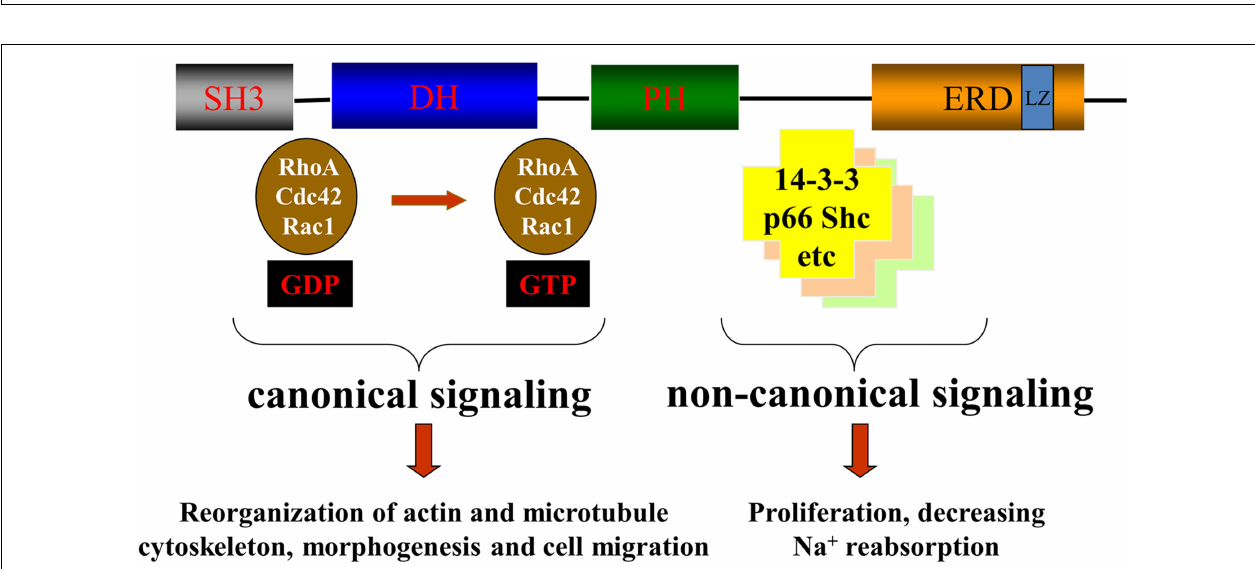
FIGURE 2 | Pix family of proteins. A schematic diagram of Pix family of proteins showing position of protein–protein interaction domains and the similarity between α Pix and β Pix. α Pix (A) and β Pix (B) – two isoforms of Pix family of proteins. β 1 Pix and β 2 Pix are two splice forms of β Pix. Domain structure is depicted. CH, calponin homology/actin binding domain; SH3, SRC Homology 3 domain; DH, DBL homology domain; PH, Pleckstrin